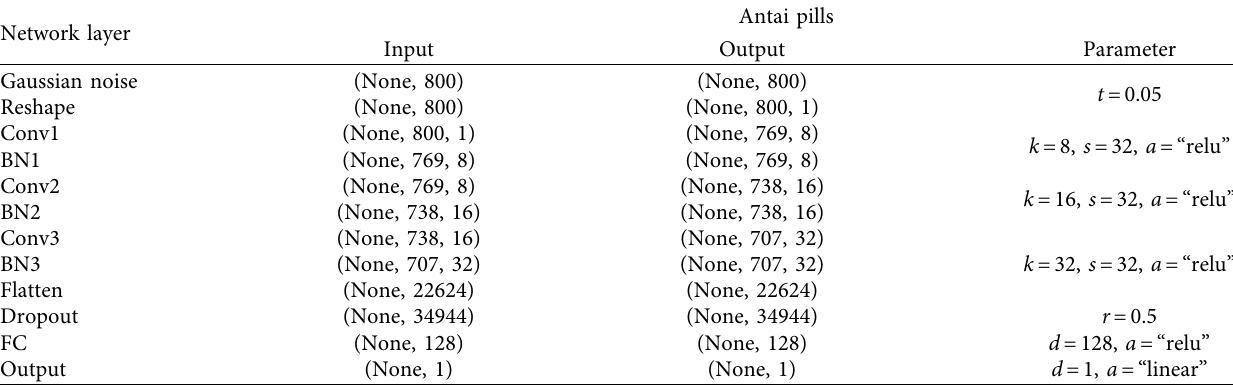
Table 1: Network structure parameters of